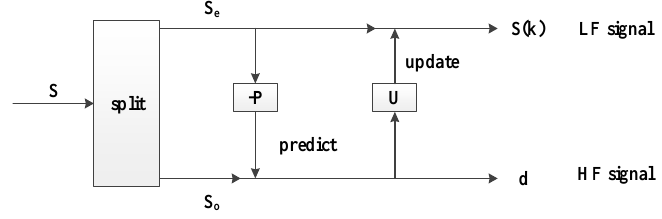
Figure 5. Diagram of lifting wavelet decomposition.